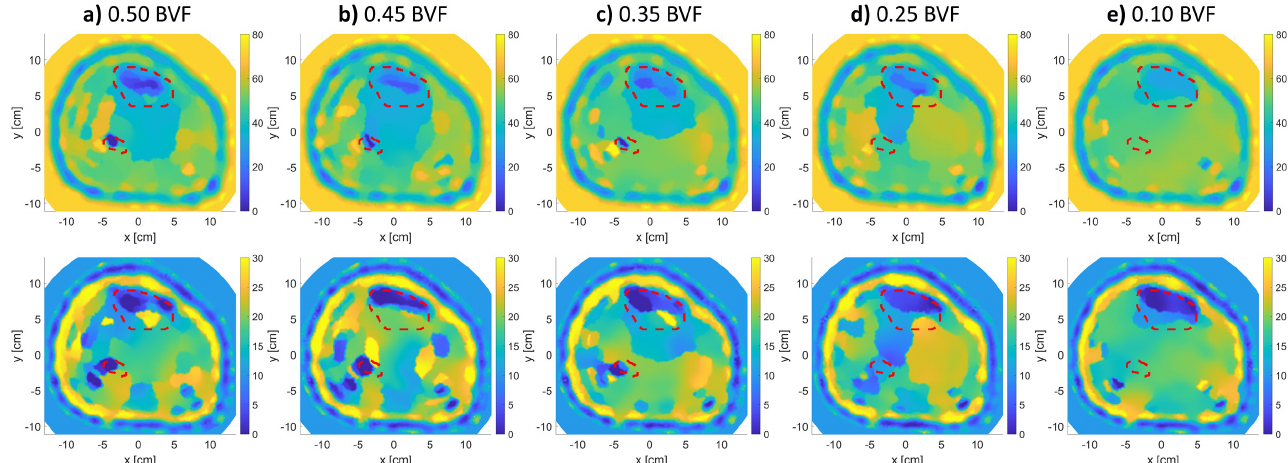
Figure 8. Relative complex permittivity reconstructions for leg model 1 with varying BVFs ( top row : real, bottom row : imaginary). The red-dotted lines indicate the bones’ actual locations.